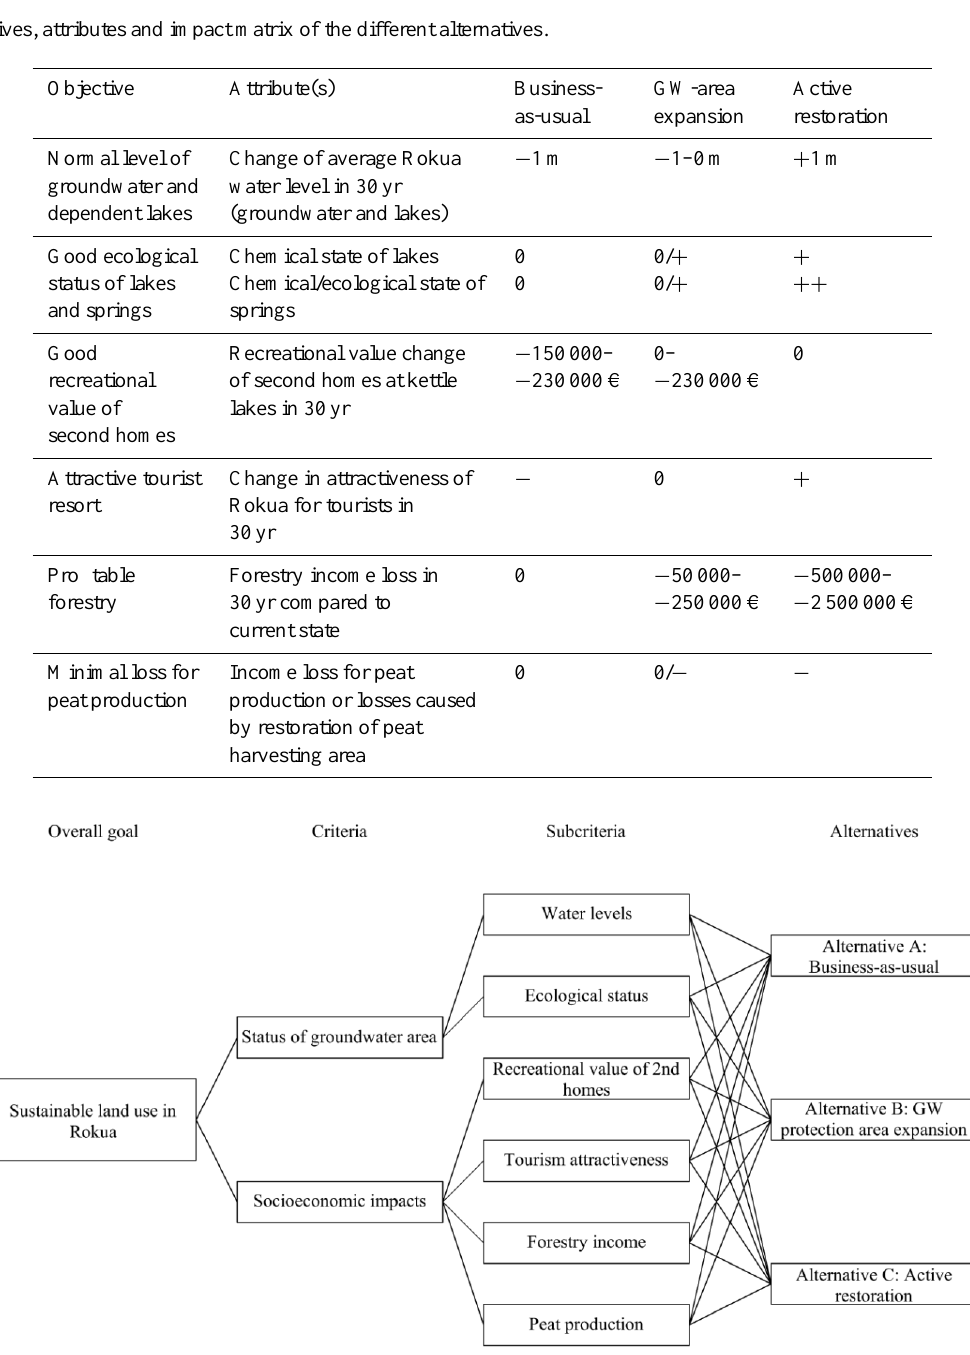
Fig. 3. Value tree for the multi-criteria decision analysis in Figure 3. Value tree for the multi-criteria decision analysis in Rokua.